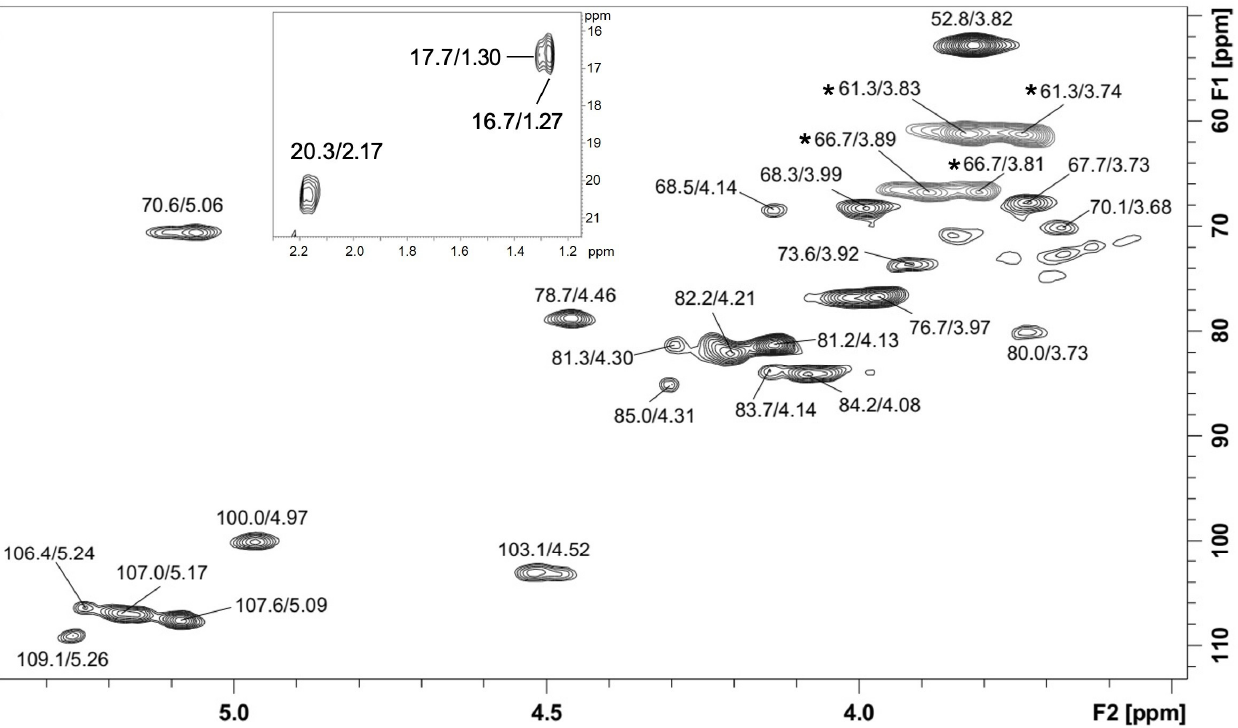
Figure 2. HSQC-DEPT correlation map of P-EA fraction in D 2 O at 70 °C, the chemical shifts are expressed as δ (ppm). Inverted signals in DEPT experiment are marked with *.